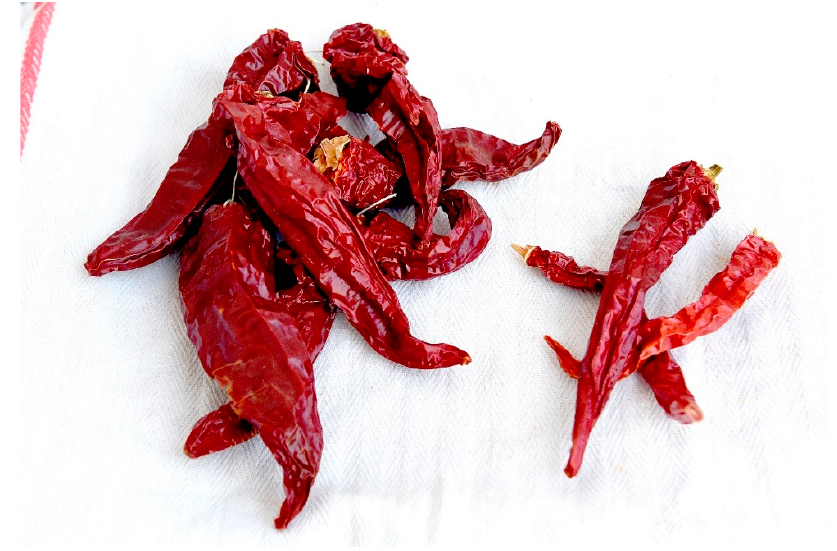
Figure 1. Sweet (left) and hot peppers (right) from Altino (Chieti, Abruzzo, Italy).